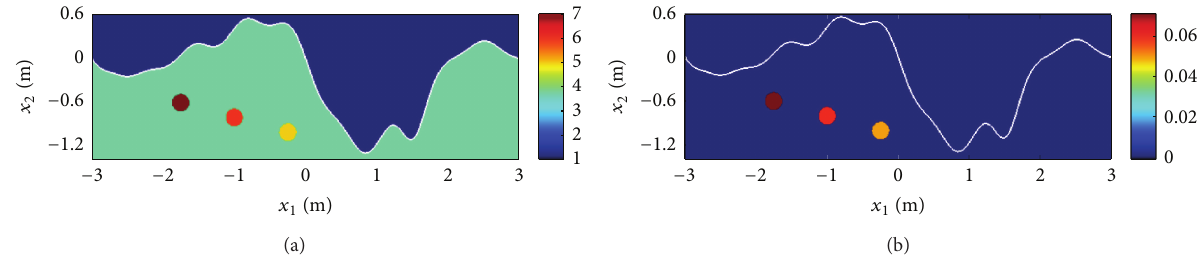
Figure 6: (a) The exact relative permittivity and (b) conductivity profiles of three circular objects and the background having a large roughness.